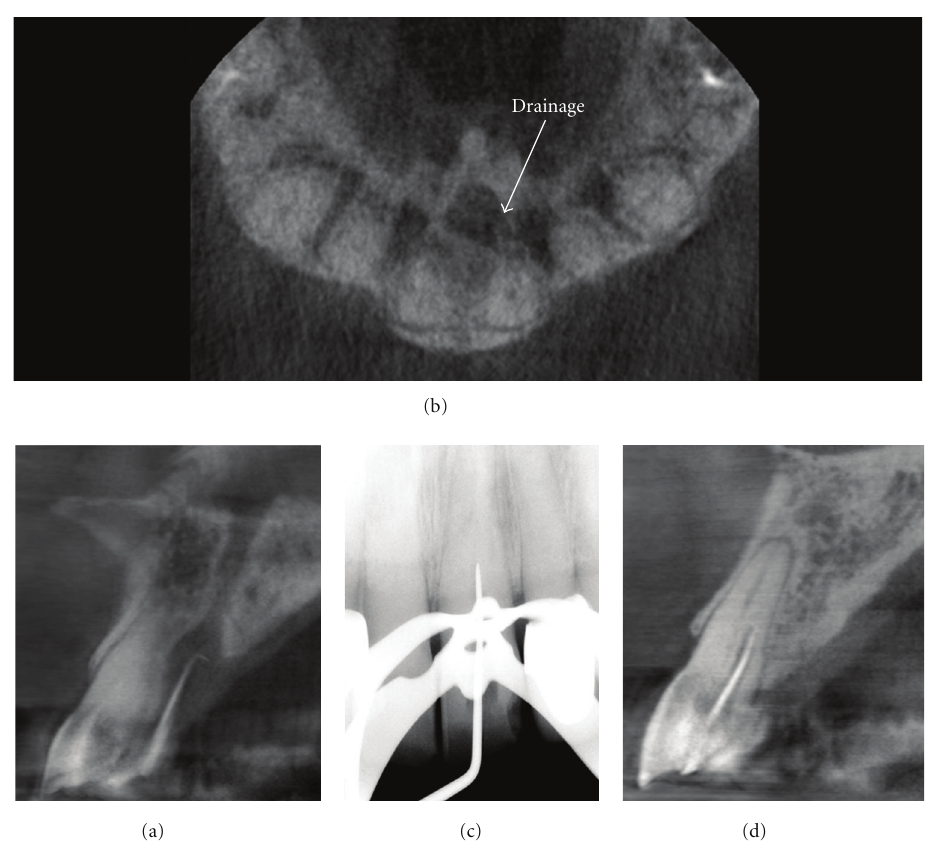
Figure 4: A 79-year-old male was referred for endodontic treatment of the maxillary left central incisor after a palatal sinus tract was noted. CBCT imaging was initially performed with a gutta percha cone marker inserted into the sinus tract to determine the source of the infection. Sagittal images (a) demonstrated that the lesion terminated at the periapex of the maxillary left central incisor after coursing through the incisive canal whereas drainage was visible on the axial image (b). Perioperatively, only the mesiodistal direction could be determined on conventional intraoral periapical radiography (c) and treatment suspended when the explorer reached 17 mm because of the danger of perforation in the facial or palatal direction. Subsequent cross-sectional perioperative CBCT imaging (d) with an intracanal gutta percha marker indicated that the initial access preparation was directed palatally. Correction of the access facially resulted in gaining access to the apical terminus; treatment was completed without